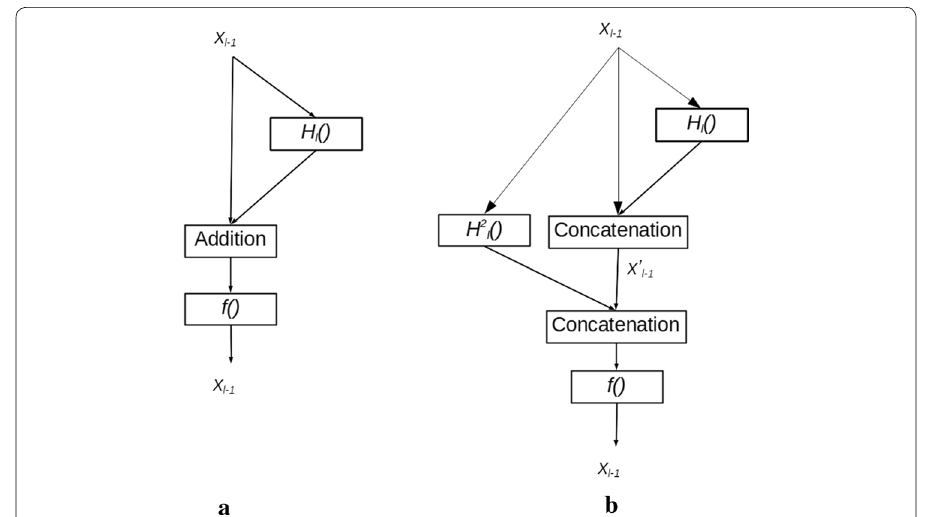
Fig. 7 Comparison of a residual networks on Xception and b concatenation layers of the proposed system